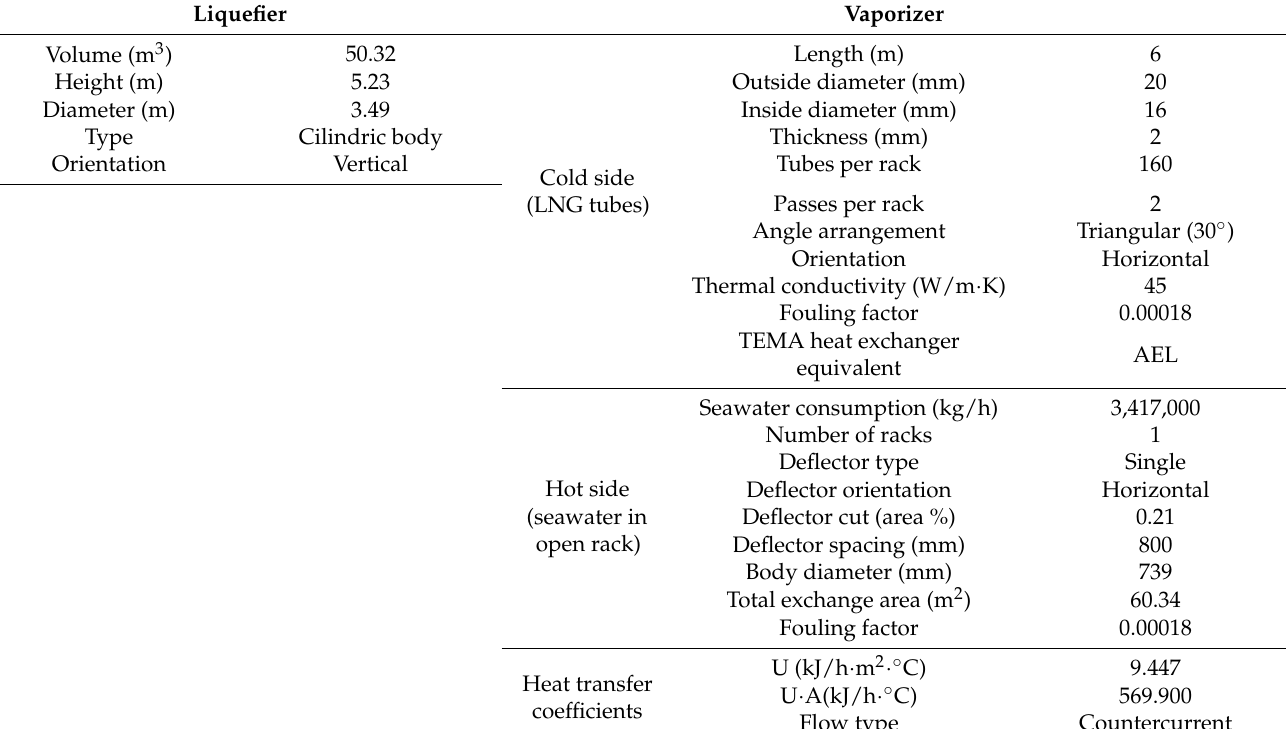
Table 9. Sizing results for conventional LNG regasification